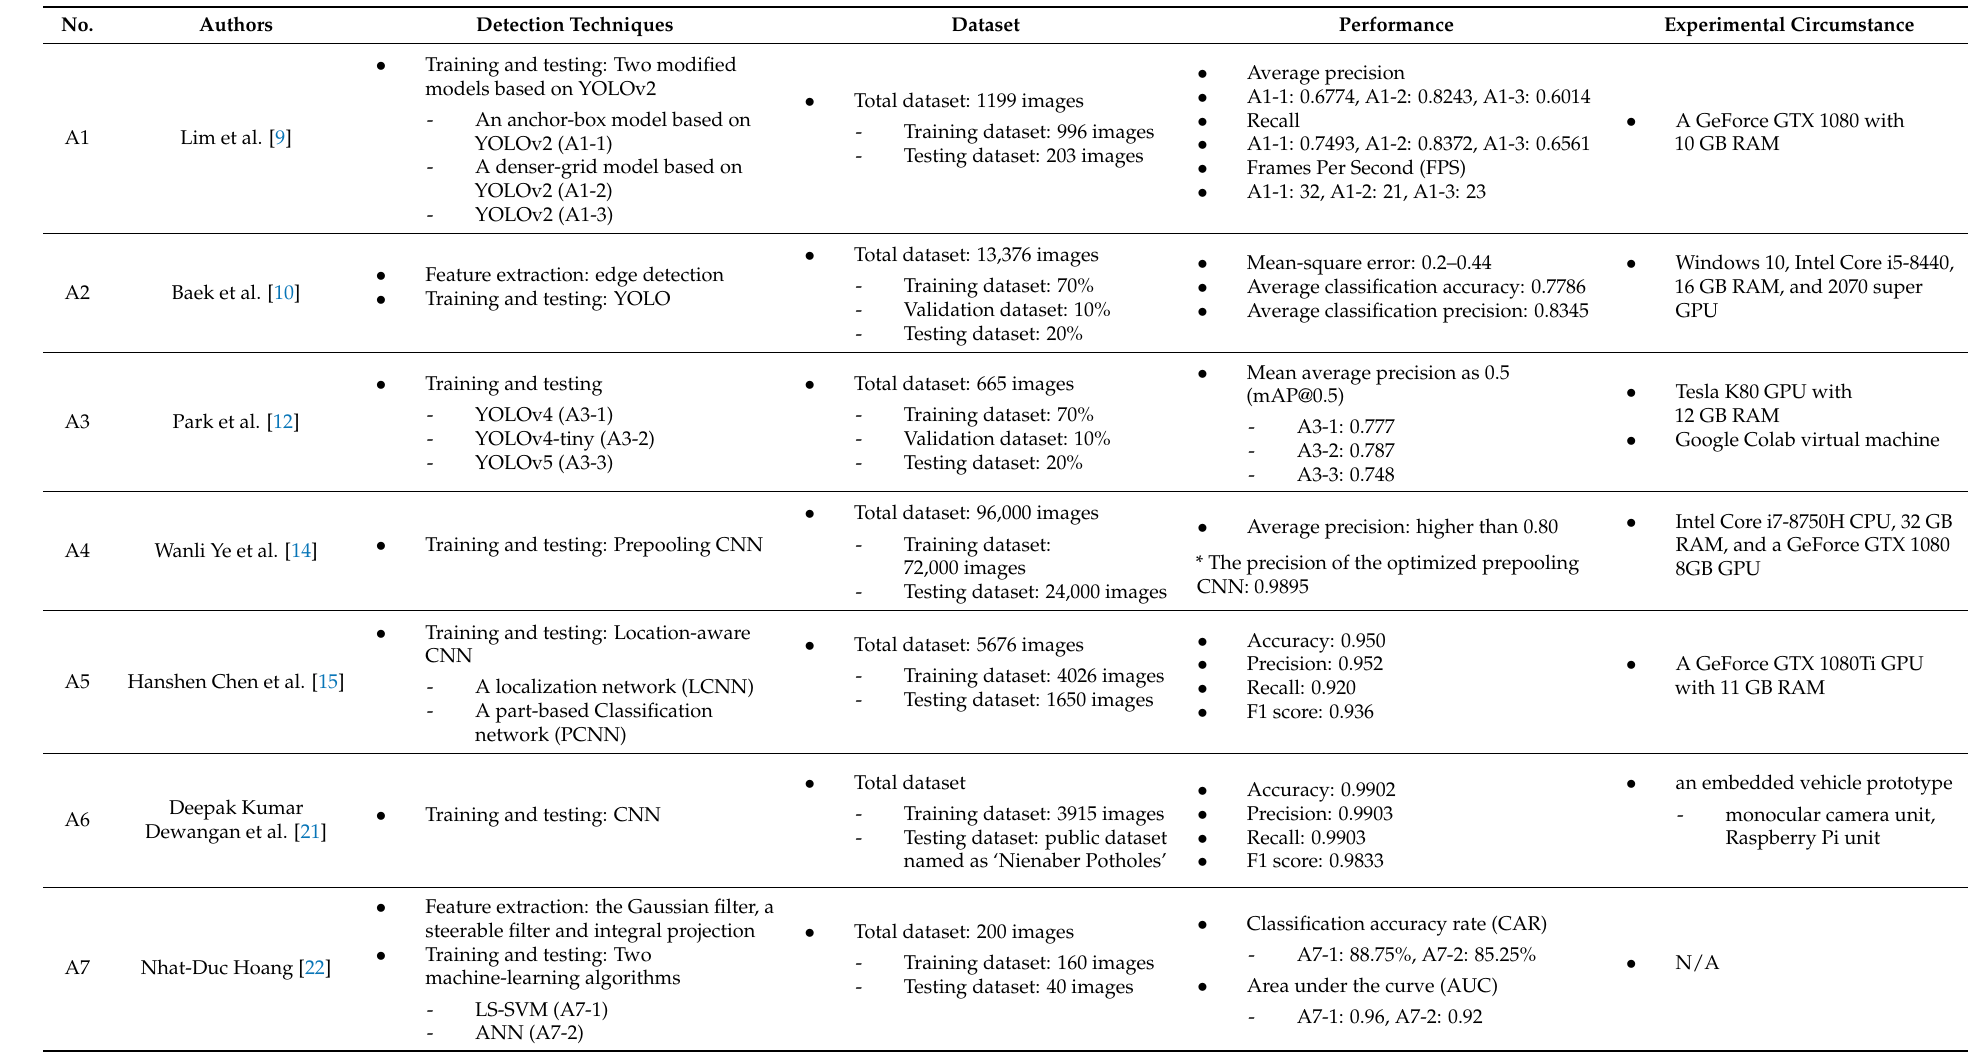
Table 2. Detection techniques and characteristics of vision-based pothole-detection